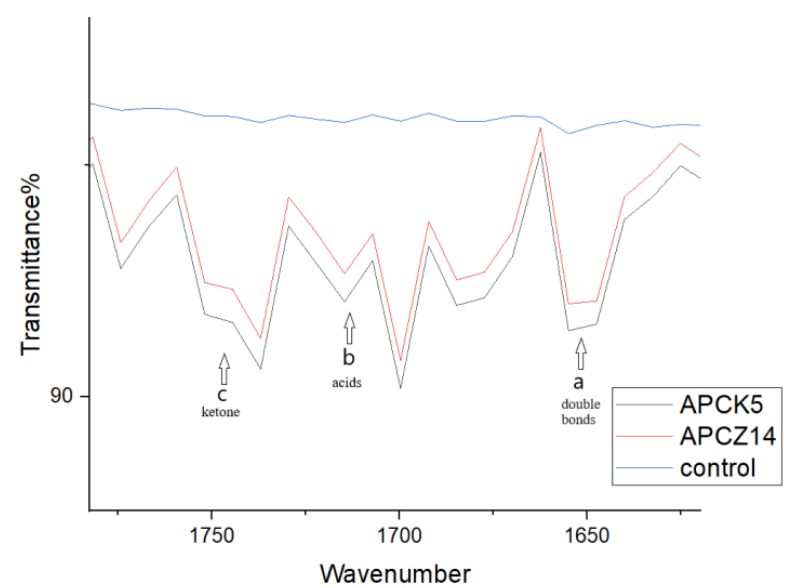
Figure 4. FTIR spectra of LDPE powder after 180-day incubation with APCK5, APCZ14 and control. ( a ) double bonds (1640 cm − 1 ), ( b ) acids (1715 cm − 1 ), and ( c ) ketones (1740 cm − 1